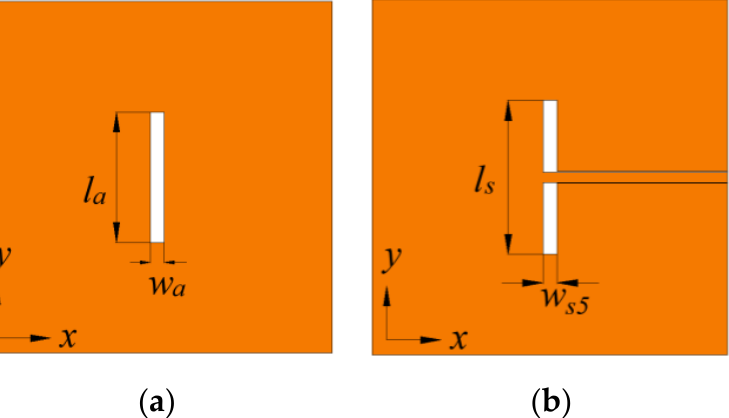
Figure 8. Design steps of the CPW-fed slot on the ground plane. ( a ) Single slot without CPW. ( b ) Original CPW-fed slot without the 5-stage gradient transitions. l s 1 = 28.00, w a = 2.80, (unit: mm).